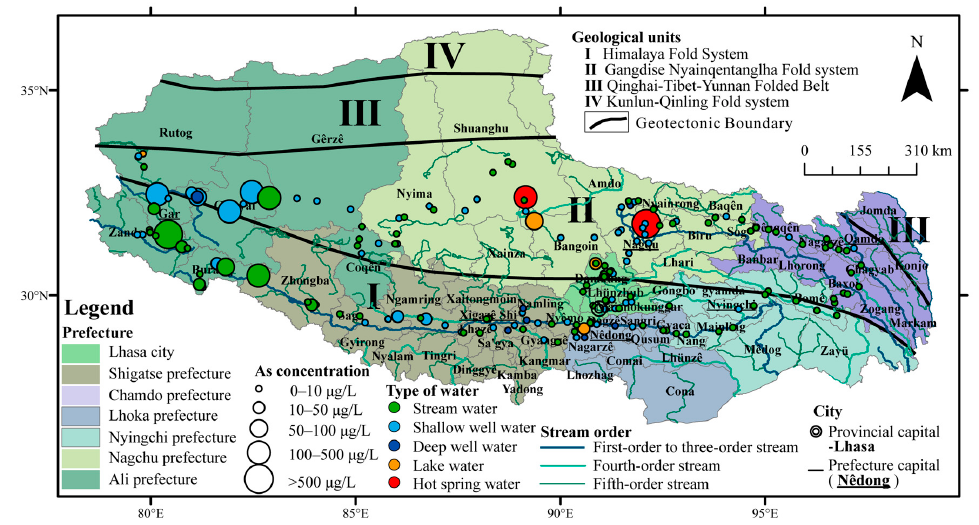
Figure 3. Administrative division, geological characteristics [26], and arsenic concentrations of different types of water in Tibet.